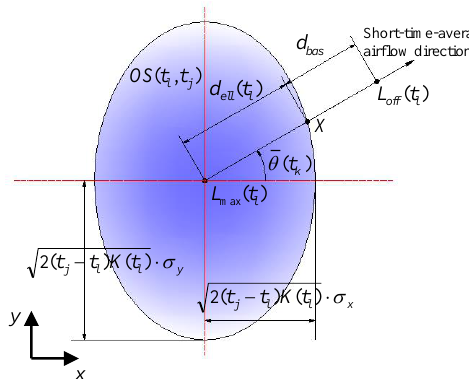
Figure 2. Generation of the deviation-path point ( )